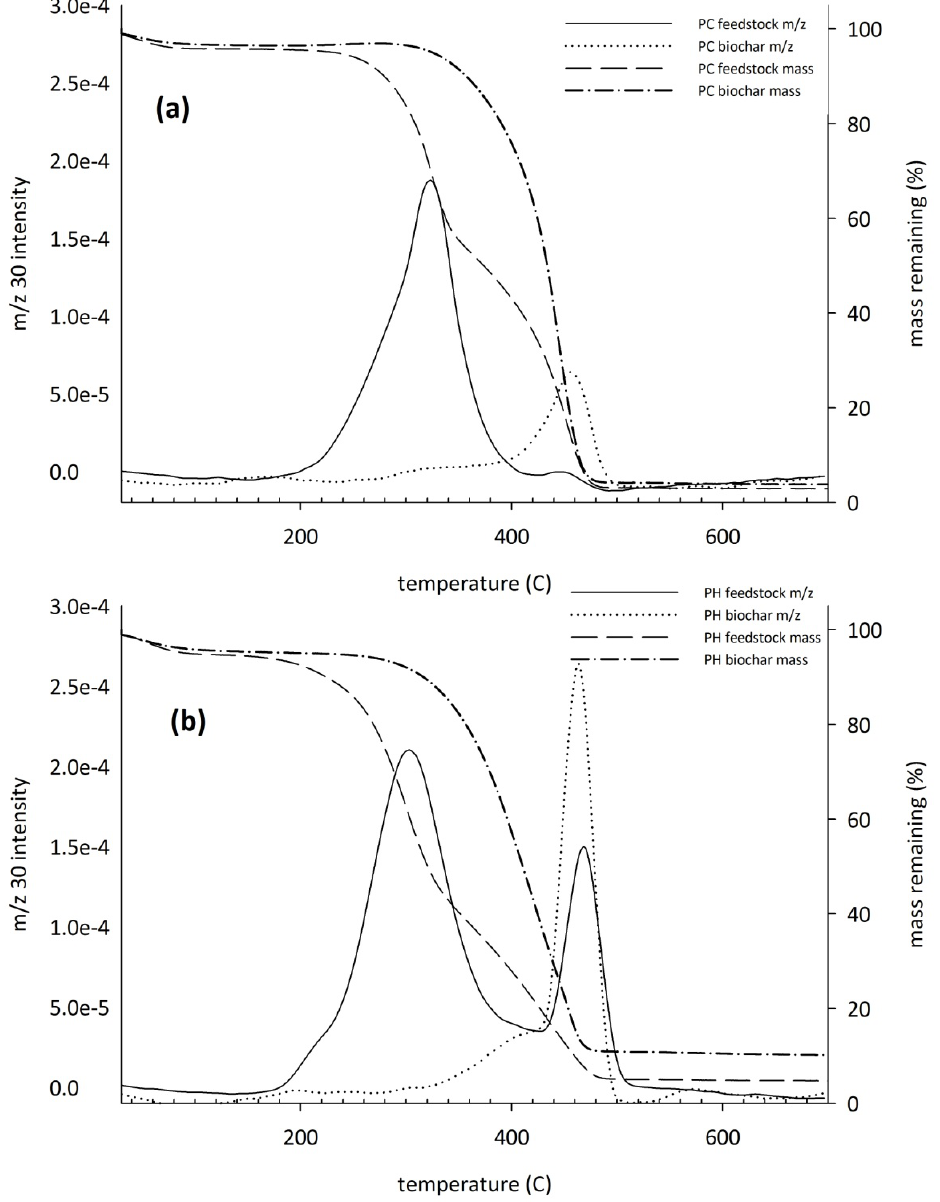
Figure 1. Combustion mass loss curve and intensity of m / z 30 (NO + ) of pine chip ( a ) and peanut hull; ( b ) biochars and